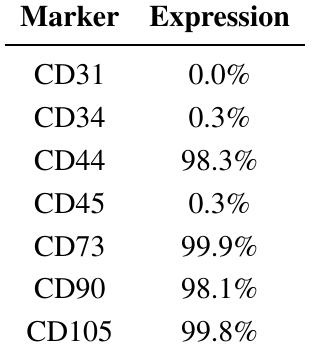
Table 1. Summarized surface antigen expression after dynamic cultivation in Z ® RP 2000 H bioreactor. Cells lack hematopoetic and endothelial surface marker expression while expressing specific MSC immunophenotypic